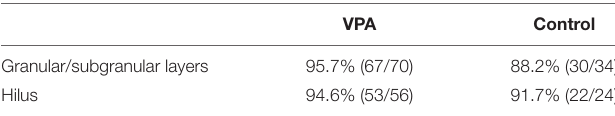
Granular/subgranular